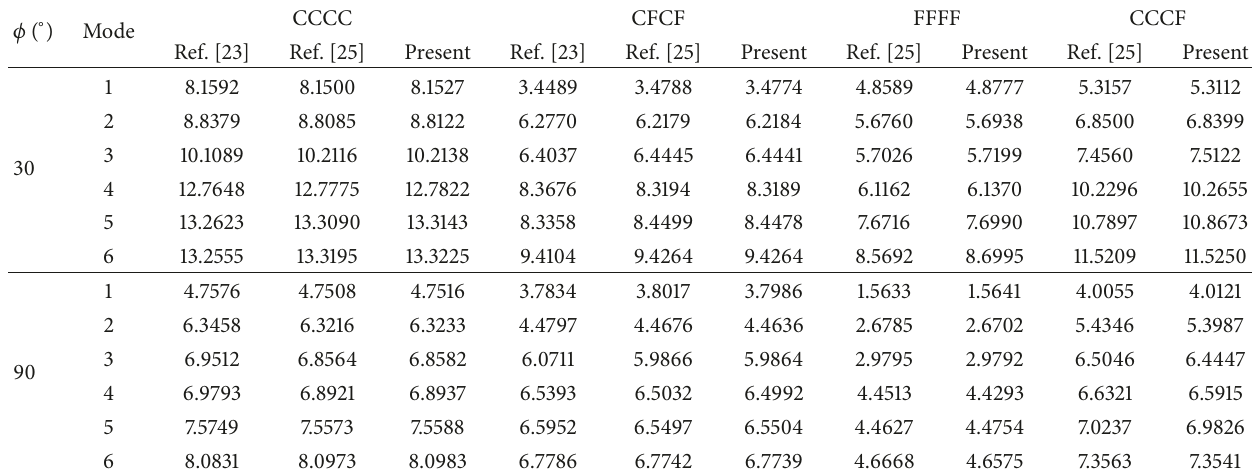
Table 2: Comparison of frequency parameters Ω = 𝜔𝑅 1 √𝜌/𝐸 for annular sector plates with various boundaries and inner-to-outer radii ratios: 𝑅 0 /𝑅 1 = 0.5